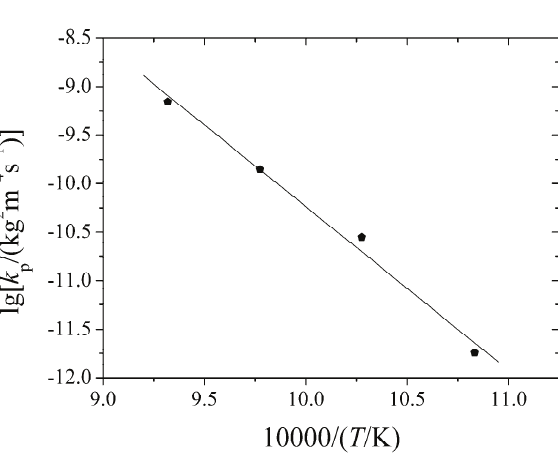
Figure 8. Arrhenius plot for the parabolic rate constants of the coating/TA15 at temperatures from 923 to 1073 K in